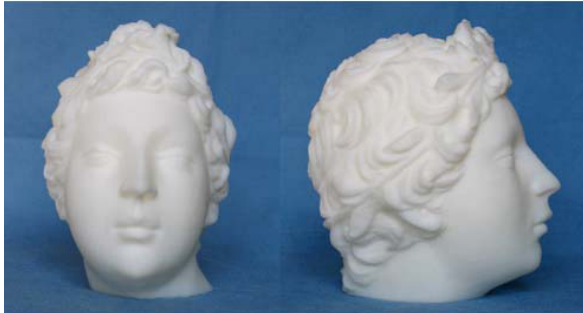
Figure 14. Real scale model of the head’s statue shown in Fig. 2 – Fuse deposition model